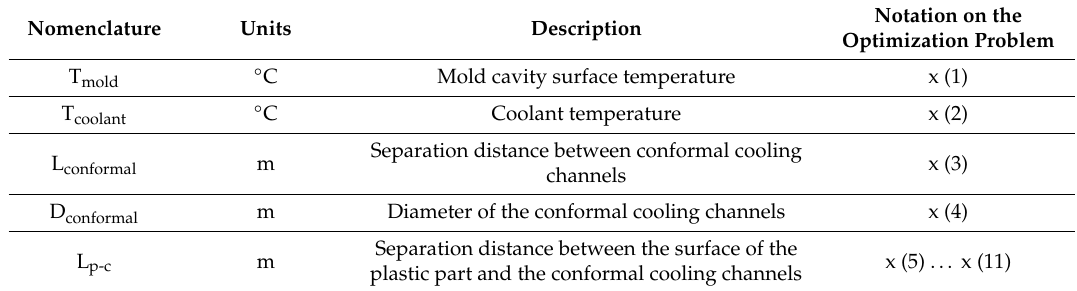
Table 2. Optimization problem